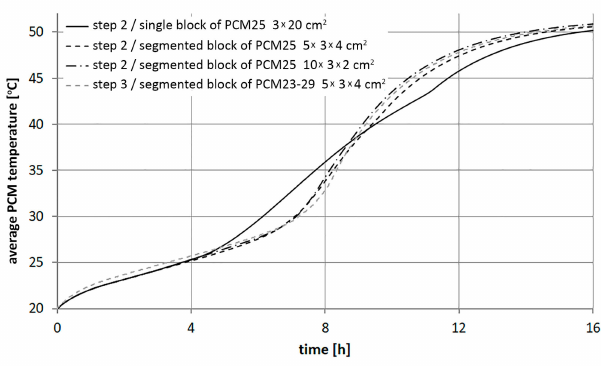
Figure 14. Comparison of the average PCM temperature for four di ff erent simulations.